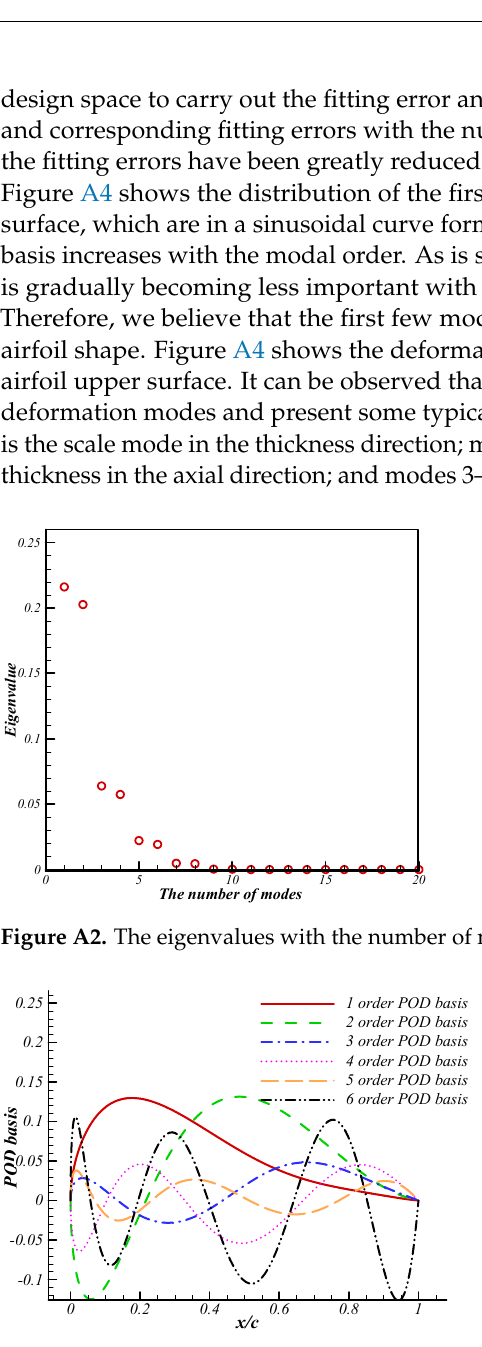
Figure A3. The first six POD basis functions of the upper surface of airfoil.